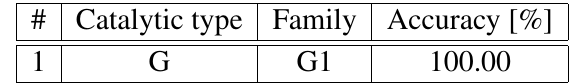
Table 9: Accuracy values for the SVM system and